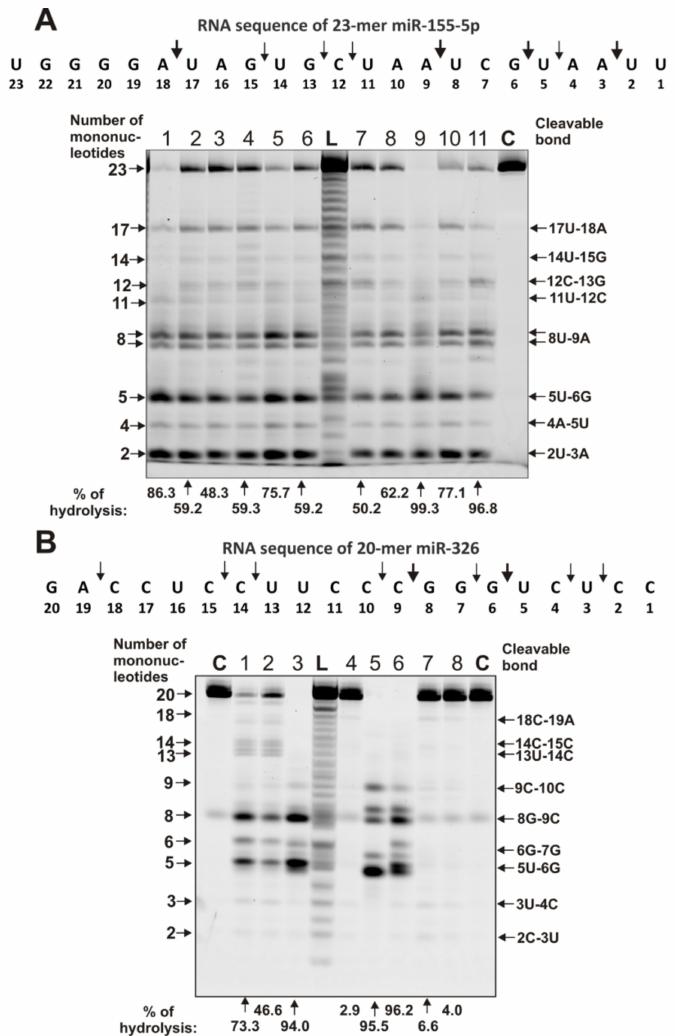
Figure 6. The patterns of splitting of oligonucleotides Flu-miR-155-5p ( A ) and Flu- miR-326 ( B ) by preparations of 0.6 µ M IgGs for 1 h of incubation from sera of 8 and 14 different MS patients. The products of hydrolysis were detected due to the fluorescent residue (Flu) on the 5 (cid:48) -ends of the miRNAs. Lane C corresponds to ONs incubated in the absence of IgGs, whereas Lane L corresponds to control oligonucleotide length markers. The numbers of IgG preparation, lengths of the products, and the percentage of microRNA cleavage by each IgG preparation are shown in panels ( A , B